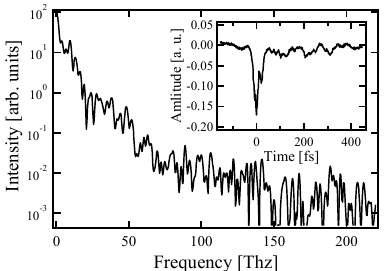
Fig. 4 Dependence of the infrared pulse spectrum on the input pulse profile. Assuming that 12 fs pulse is Fourier transform limited, reflections times on chirped mirrors is decreased or increased. The case of 37-fs laser pulse is also shown.